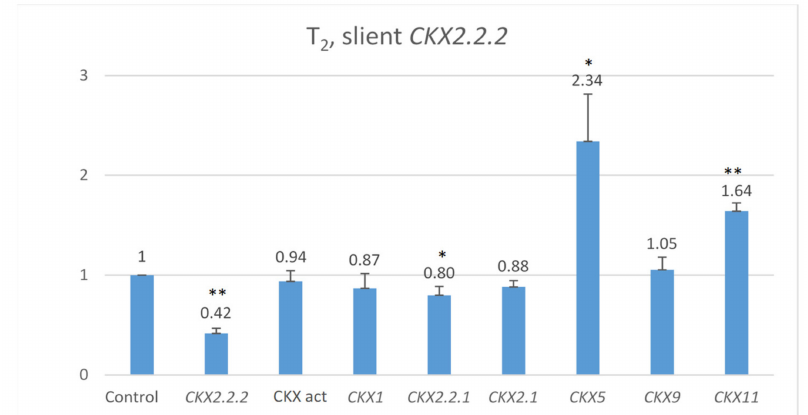
Figure 3. Relative expression of other TaCKX GFMs in 7 DAP spikes, related to the control, non-silent TaCKX2.2.2 set as 1.00, and relative CKX enzyme activity (CKX act bar). The error bars denote ± SE. *—significant at p ≤ 0.05; **—significant at p ≤ 0.01.